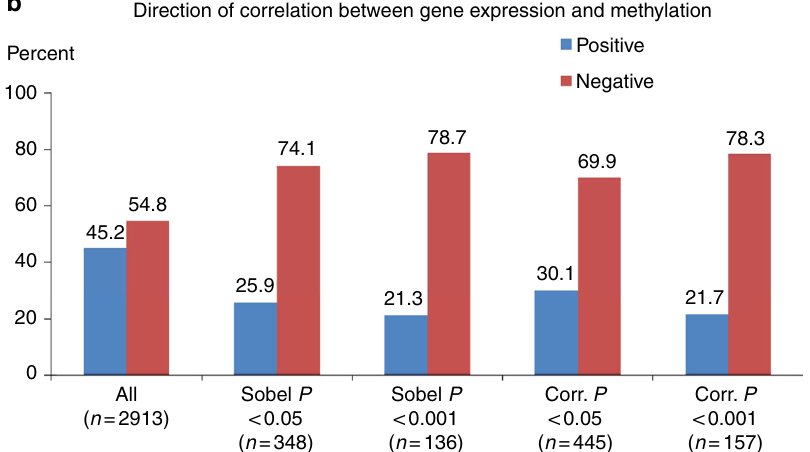
Fig. 6 Direction of QTL effects and associations between expression and methylation for co-localized eQTL-meQTL pairs. Results for 2913 potentially co- localized eQTL-meQTL pairs identi fi ed using a p 12 value 4.4× 10 − 4 are presented (results for additional p 12 values are presented in